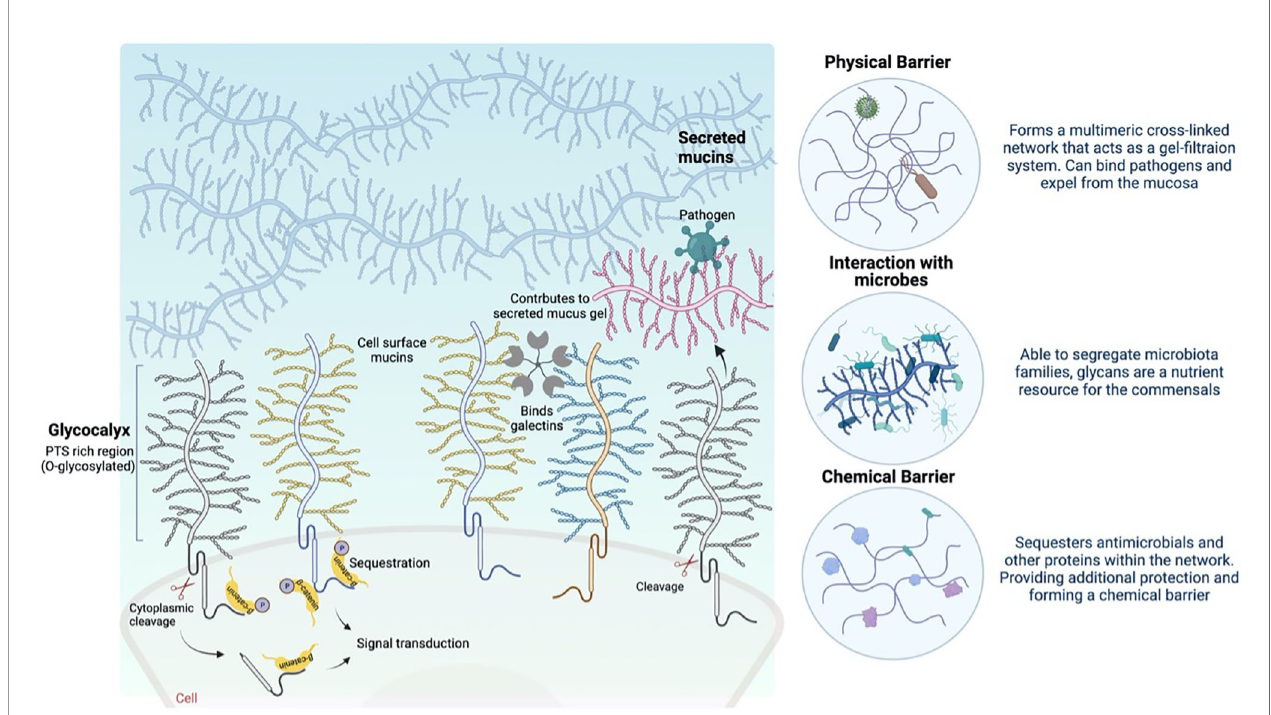
FIGURE 1 | Schematic depicting the role of cell surface and gel-forming mucins at the mucosal barrier (created with